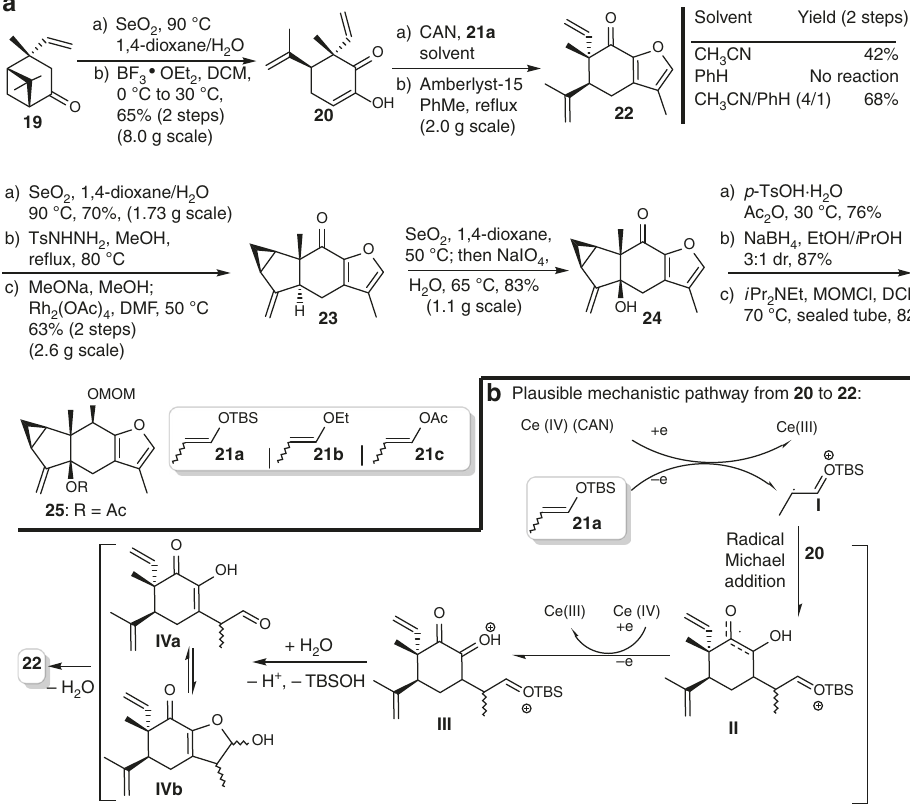
Fig. 3 Synthesis of the diene precursor 25 . a Compound 25 can be synthesized from compound 19 in 11 steps. b The mechanism for formation of 22 was proposed. DCM = dichloromethane, DMF = N,N -dimethylformamide, Ac = acetyl, DIPEA = N,N -diisopropylethylamine, MOMCl =